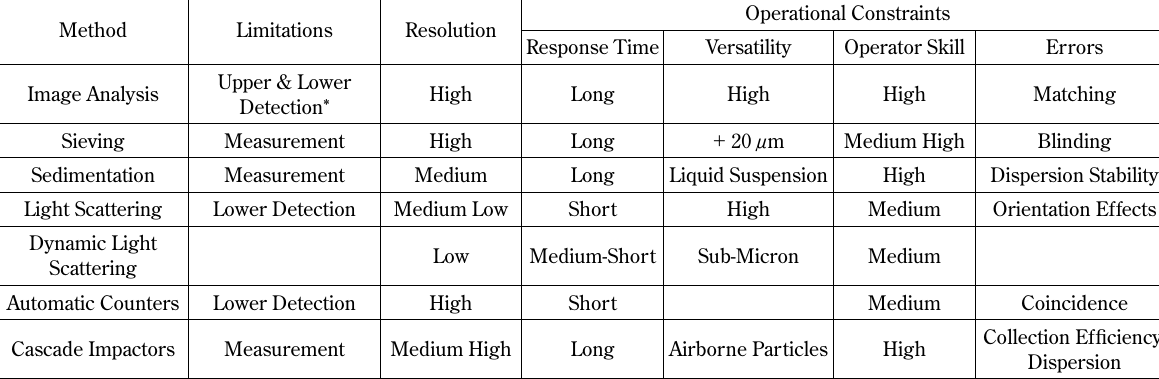
Table 3 Performance characteristics of experimental procedures for particle size analysis